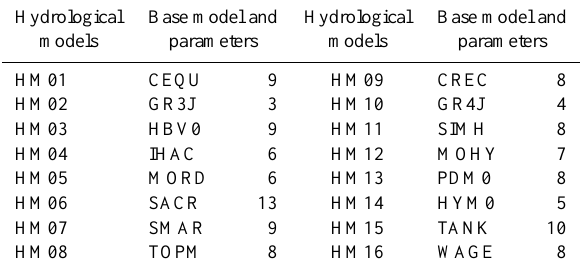
Table 2. Hydrological